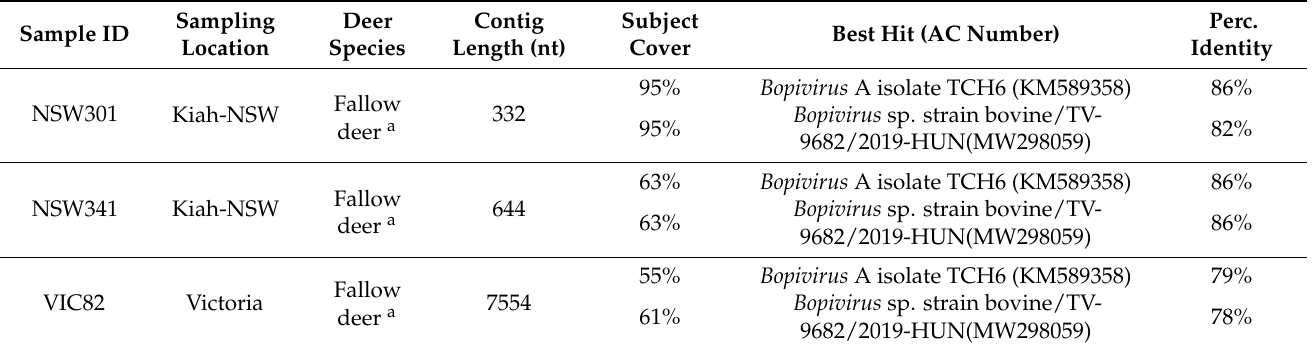
Table 1. Percentage identities of the assembled contigs for the Picornaviridae